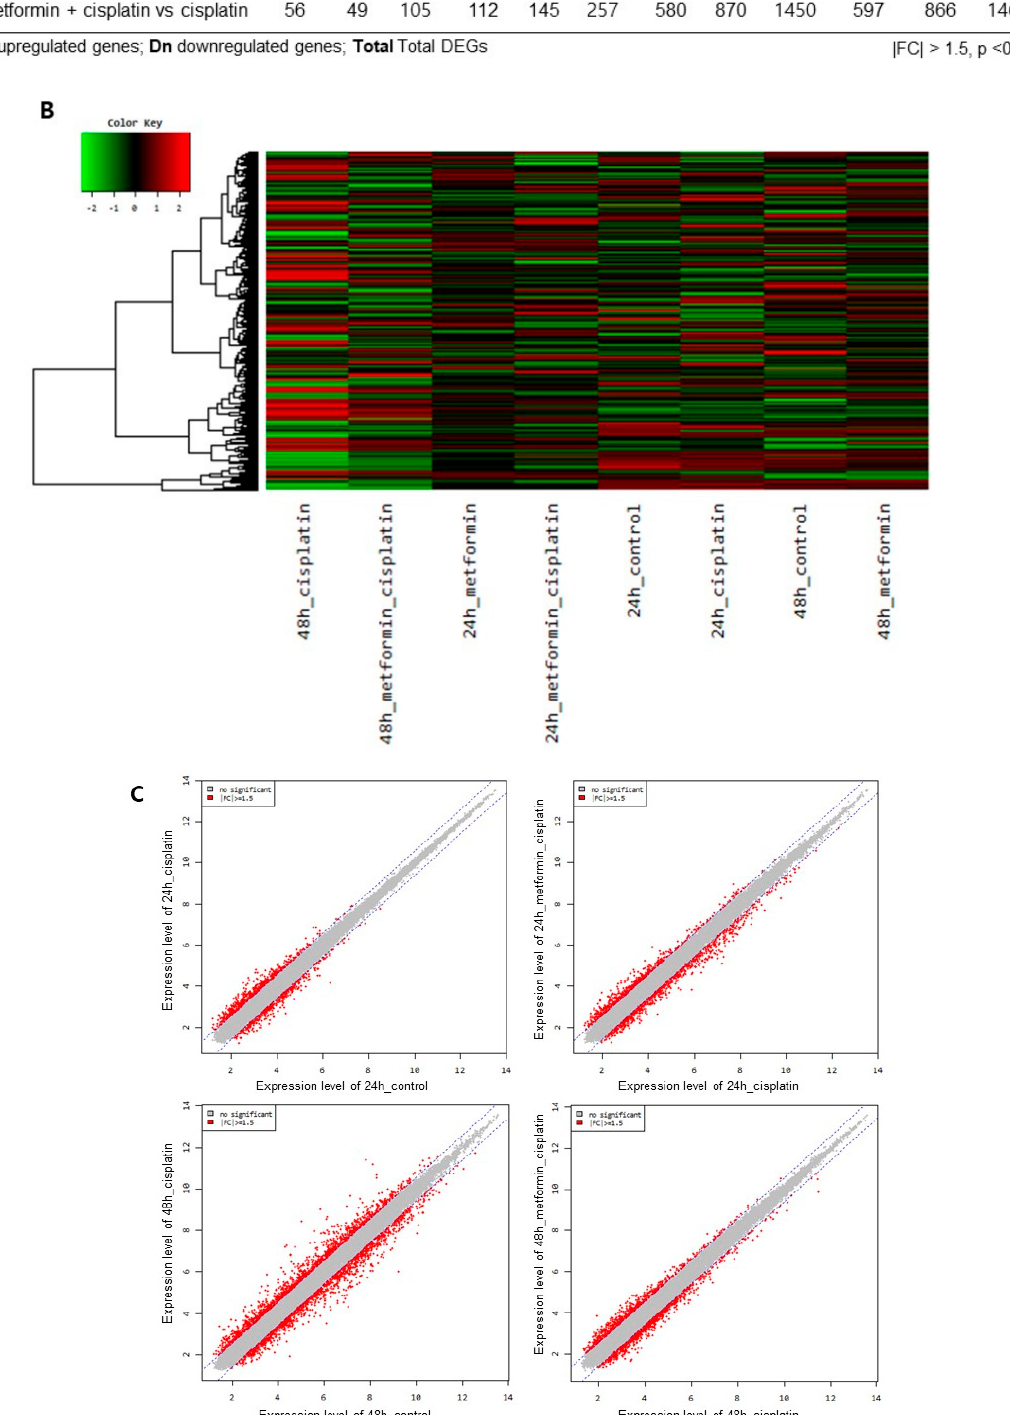
Figure 2. Heatmap and volcano plots of RNA sequencing results. ( A ). A total of 89 genes were differentially expressed with |fold change| > 1.5 ( p < 0.05) after 6 h, a total of 433 genes were differ- entially expressed after 15 h, a total of 941 genes were differentially expressed after 24 h, and a total of 2,764 genes were differentially expressed after 48 h in cisplatin group. When metformin was pre- treated for 24 h prior to application of cisplatin, a total of 105 genes were differentially expressed with |fold change| > 1.5 ( p < 0.05) after 6 h of cisplatin exposure, a total of 257 genes were differen- tially expressed after 15 h, a total of 1,450 genes were differentially expressed after 24 h, and a total of 1,463 genes were differentially expressed after 48 h. ( B ). In the heatmap, the DEGs between the various selected biological conditions were analyzed (|fold change| > 1.5 and p < 0.05). Red indicates transcripts with high expression, and green indicates transcripts with low expression. C. Plots of expression level were drawn for comparisons between the control and cisplatin group, the metfor- min pretreated group and cisplatin group. To identify the differentially expressed genes (DEGs) between groups, we generated a heat map of the expression values of the selected DEGs comparing across genes and samples (|fold change| > 1.5 and p < 0.05). The DEGs between the various selected biolog- ical conditions (Figure 2B). Additionally, plots of expression level were drawn for com- parisons between the control and cisplatin group; the metformin pretreated group and cisplatin group (Figure 2C). Cisplatin induced significant changes in gene expression after 24 h and 48 h exposure; metformin pretreatments also induced significant changes in gene expression. KEGG pathway analysis revealed that cisplatin caused a change in the expression of genes involved in microRNAs in cancer, retinol metabolism, metabolic pathways in 24 h cisplatin group and metabolic pathways, microRNAs in cancer, PI3K-Akt signaling path- way, transcriptional misregulation in cancer, MAPK signaling pathway, pathways in can- cer, axon guidance, proteoglycans in cancer, Rap1 signaling pathway, focal adhesion, p53 signaling pathway, cytokine–cytokine receptor interaction, TNF signaling pathway, en- docytosis, FoxO signaling pathway and so on in 48 h cisplatin group (Table S1, Table S2). When metformin was pretreated, cisplatin caused a change in the expression of genes in- volved in transcriptional misregulation in cancer, microRNAs in cancer, PI3K-Akt signal- ing pathway, axon guidance, Rap1 signaling pathway, serotonergic synapse, focal adhe- sion, cytokine–cytokine receptor interaction, inflammatory mediator regulation of TRP channel, serotonergic synapse, metabolic pathways, p53 signaling pathway, pathways in cancer, tight junction and so on in 24 h metformin-pretreated group (Table 1, Table S3). Additionally, when metformin was pretreated, cisplatin caused a change in the expression of genes involved in microRNAs in cancer, cytokine–cytokine receptor interaction, phag- osome, osteoclast differentiation, TNF signaling pathway in 48 h metformin-pretreated group (Table 2, Table S4).